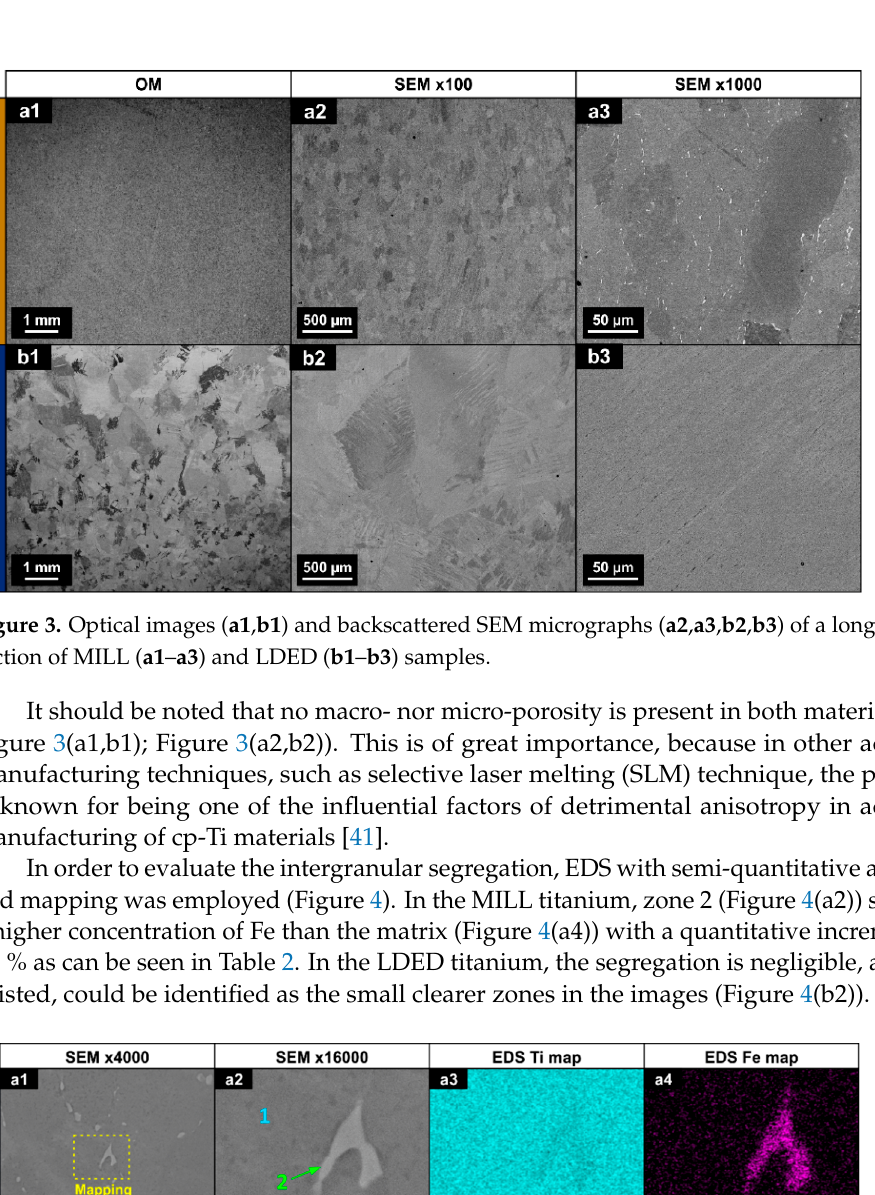
Figure 3. Optical images ( a1,b1 ) and backscattered SEM micrographs ( a2,a3,b2,b3 ) of a longitudi- nal section of MILL ( a1–a3 ) and LDED ( b1–b3 ) samples.